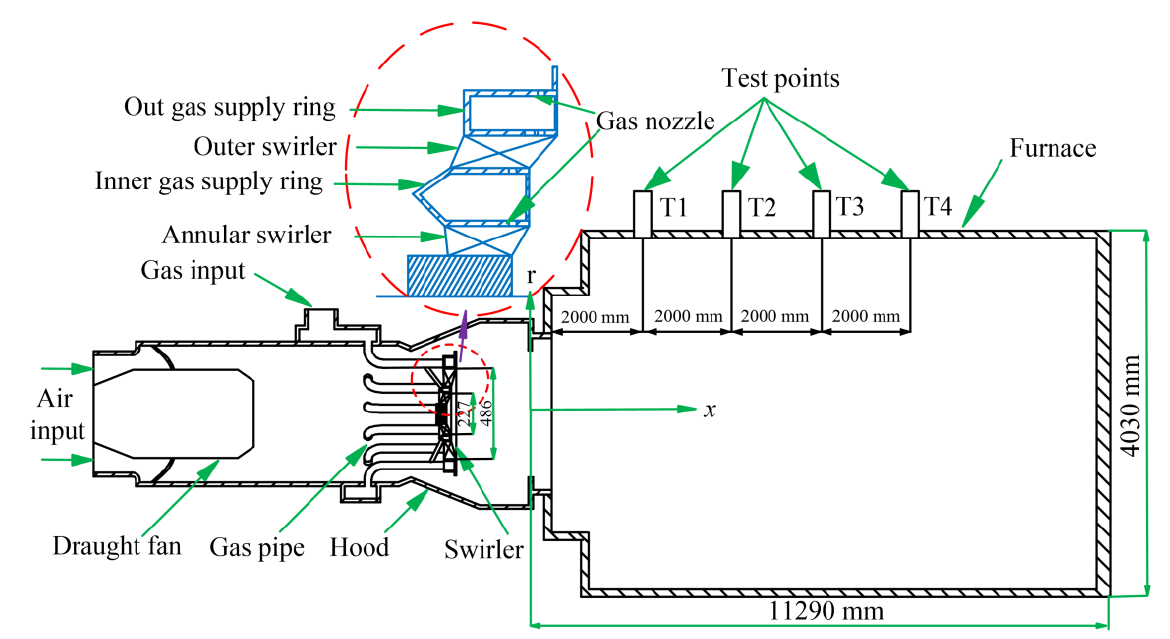
Figure 1. Schematic of the combustor geometry.